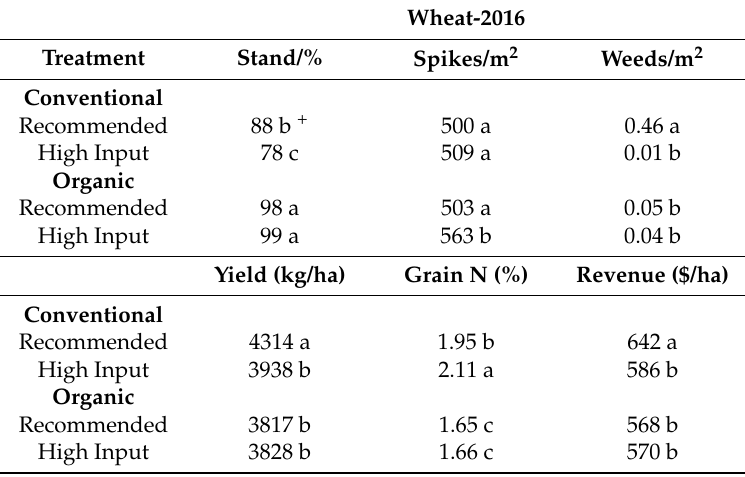
Table 5. Percent stand (early plant establishment), spikes/m 2 at harvest, weed densities in the early spring, grain yield, grain N%, and revenue of wheat in 2015–2016 under conventional and organic cropping systems at recommended and high input management in central